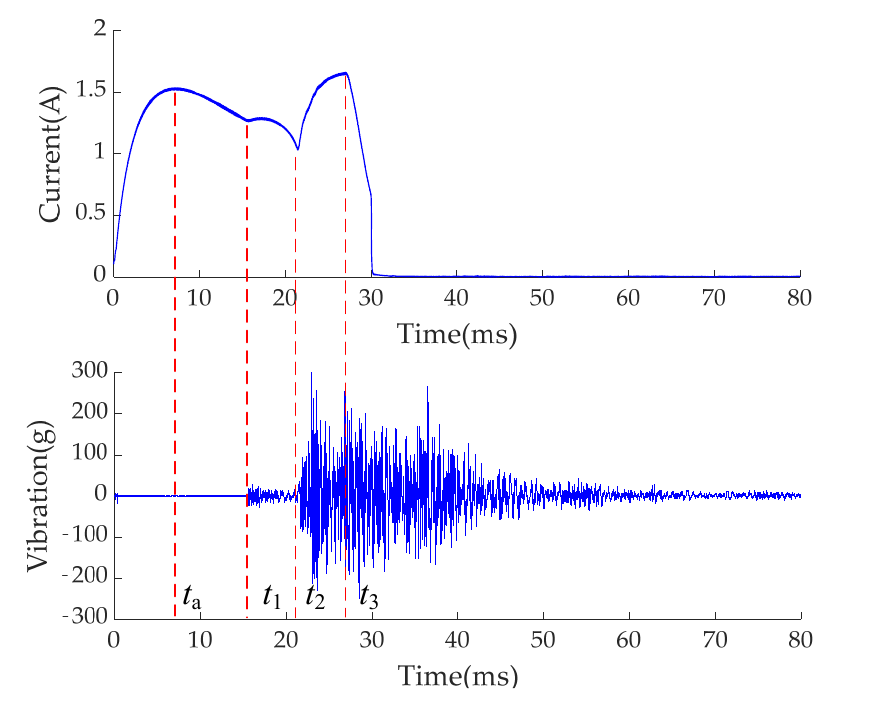
Figure 2. Measurement results of the signals.